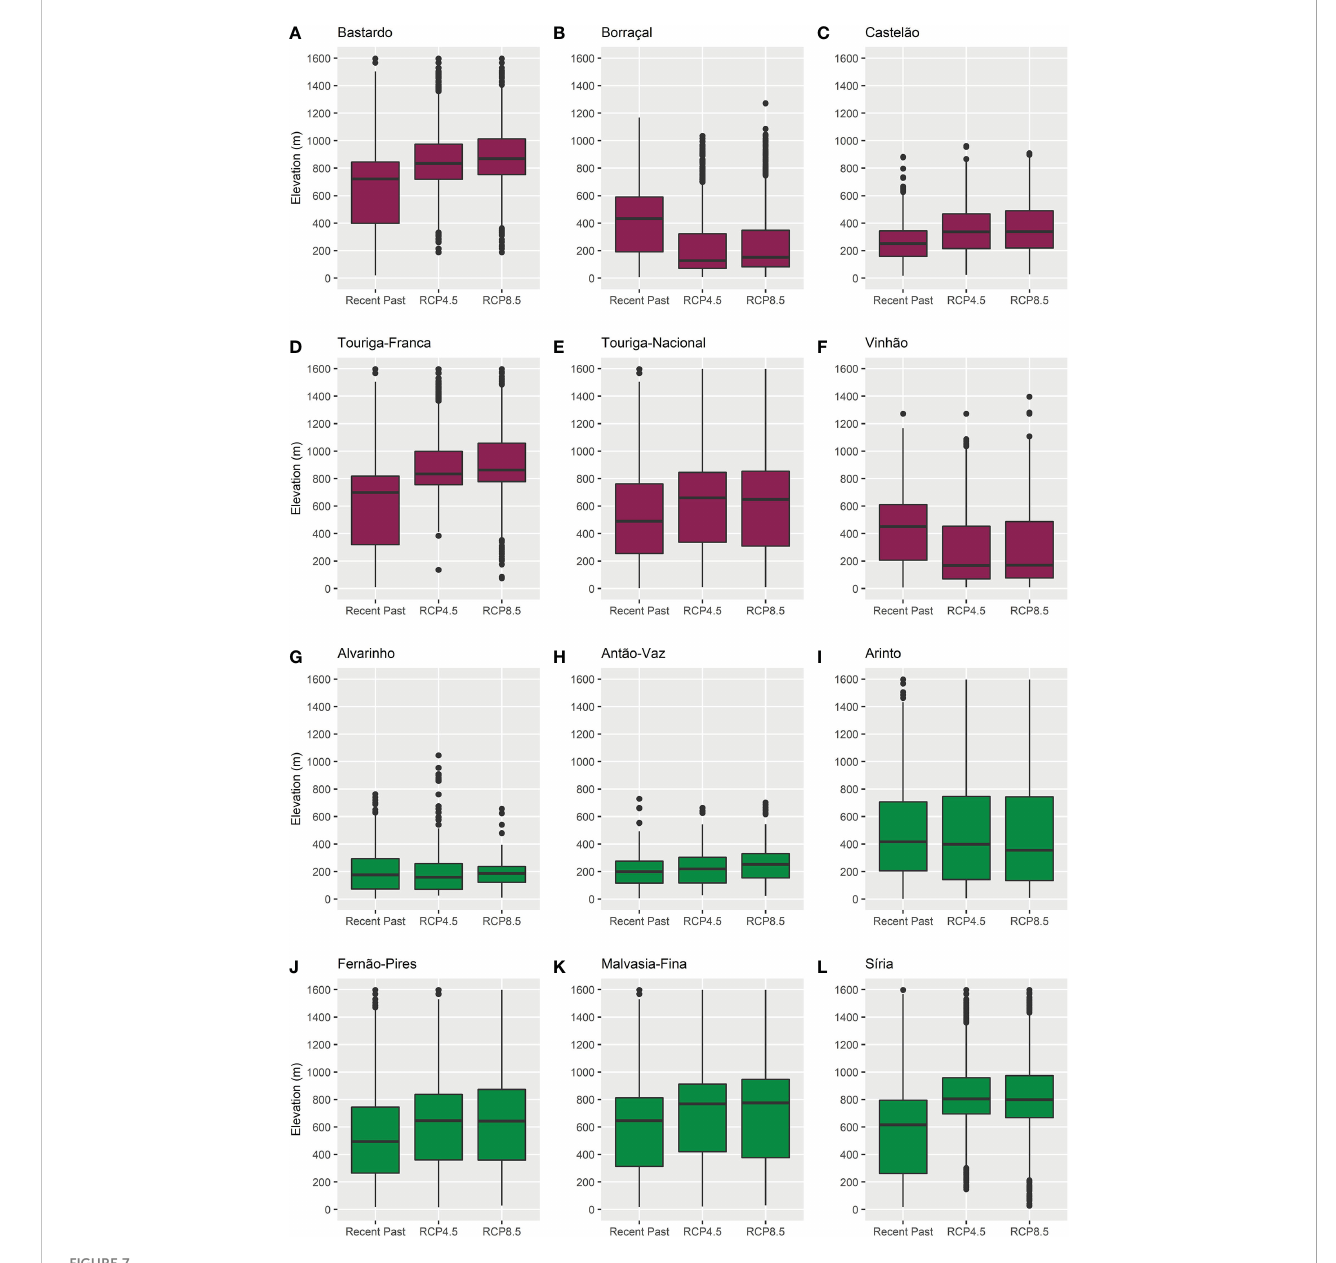
FIGURE 7 Boxplots of the distribution of bioclimatic suitability, above 20% probability of occurrence, in regards to elevation, for varieties (A) Bastardo, (B) Borrac ̧ al, (C) Castelão, (D) Touriga-Franca, (E) Touriga-Nacional, (F) Vinhão, (G) Alvarinho, (H) Antão-Vaz, (I) Arinto, (J) Fernão-Pires, (K) Malvasia-Fina, and (L) S ı ́ ria, in the recent past (1989 – 2005) and future (2021 – 2050) climates. Red boxplots identify red varieties and green boxplots identify white